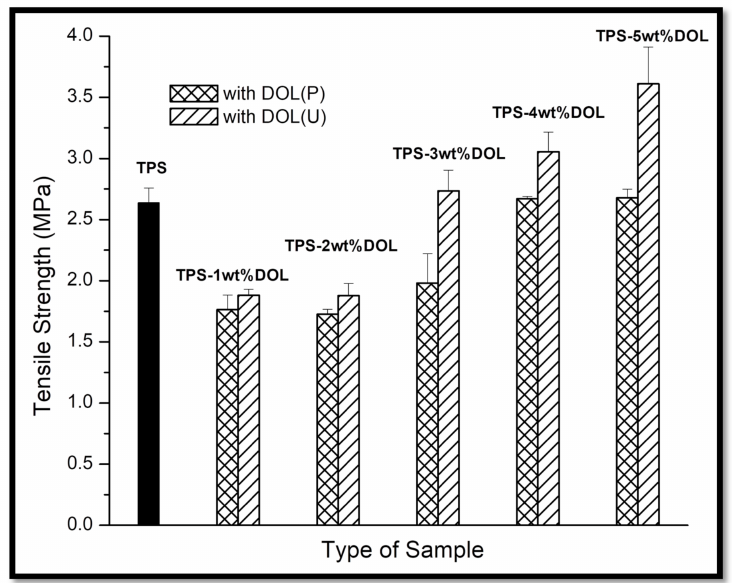
Figure 10. Tensile strength of TPS film and TPS-DOL biocomposite